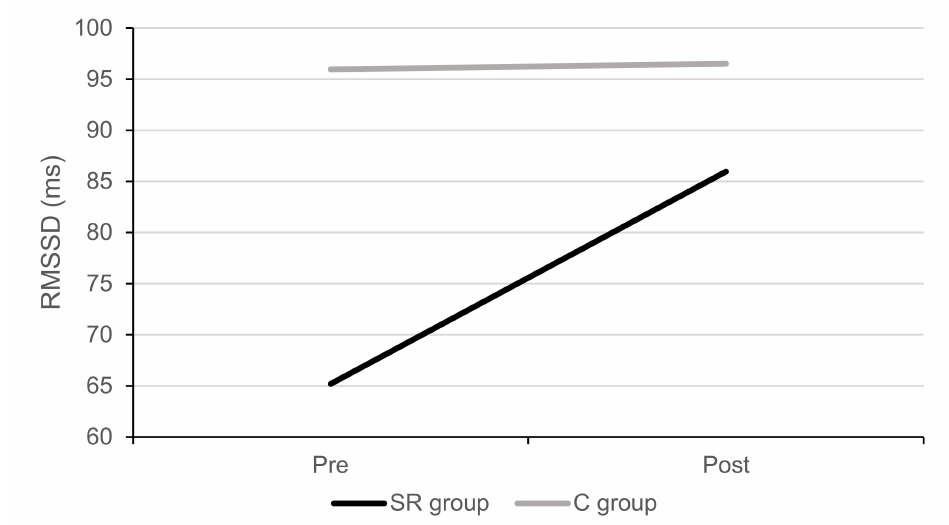
Figure 3. Root mean square of successive differences between RR intervals (RMSSD) for heart rate variability during sleep at the beginning and the end of the training